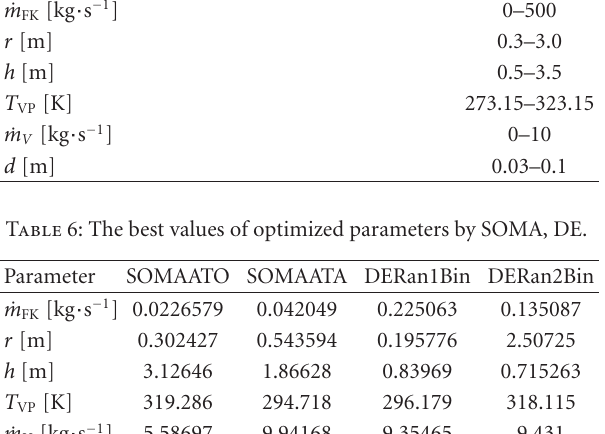
Table 10: Estimated parameters for SOMAATO.